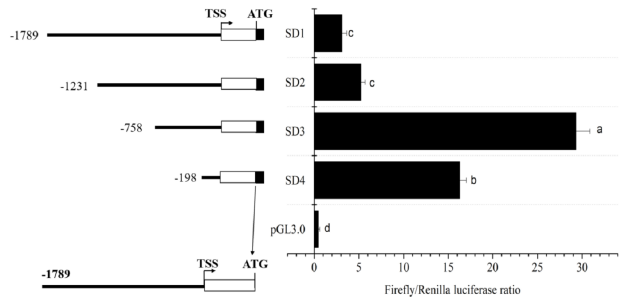
Figure 4. Structure and progressive deletion analysis of grouper acsl6 promoter: 5′ deletion constructs are shown on the upper left, and the structure of acsl6 promoter is showed on the lower left. Noncoding exons are indicated with open boxes, and luciferase coding frames are indicated by closed